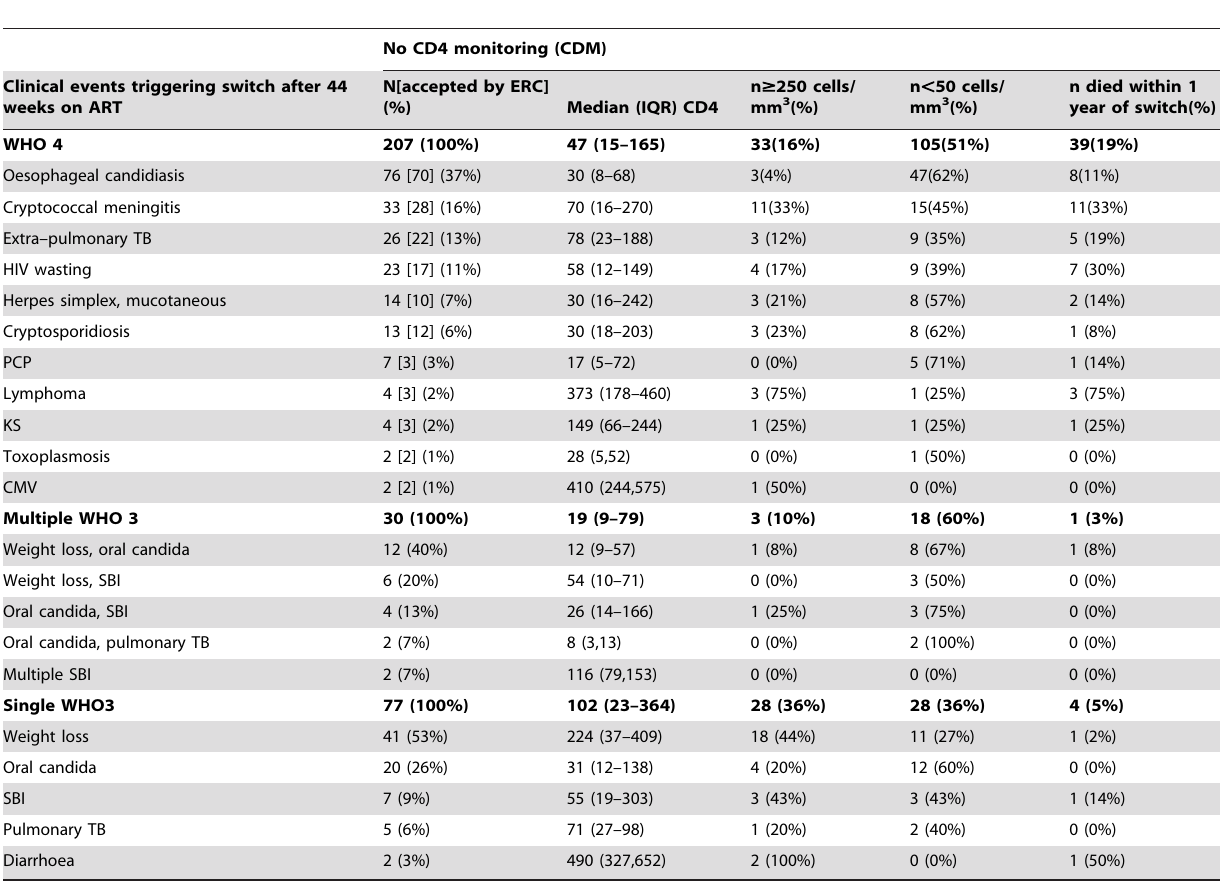
Table 3. Clinical events triggering switch after 44 weeks on ART in patients monitored without CD4 cell counts